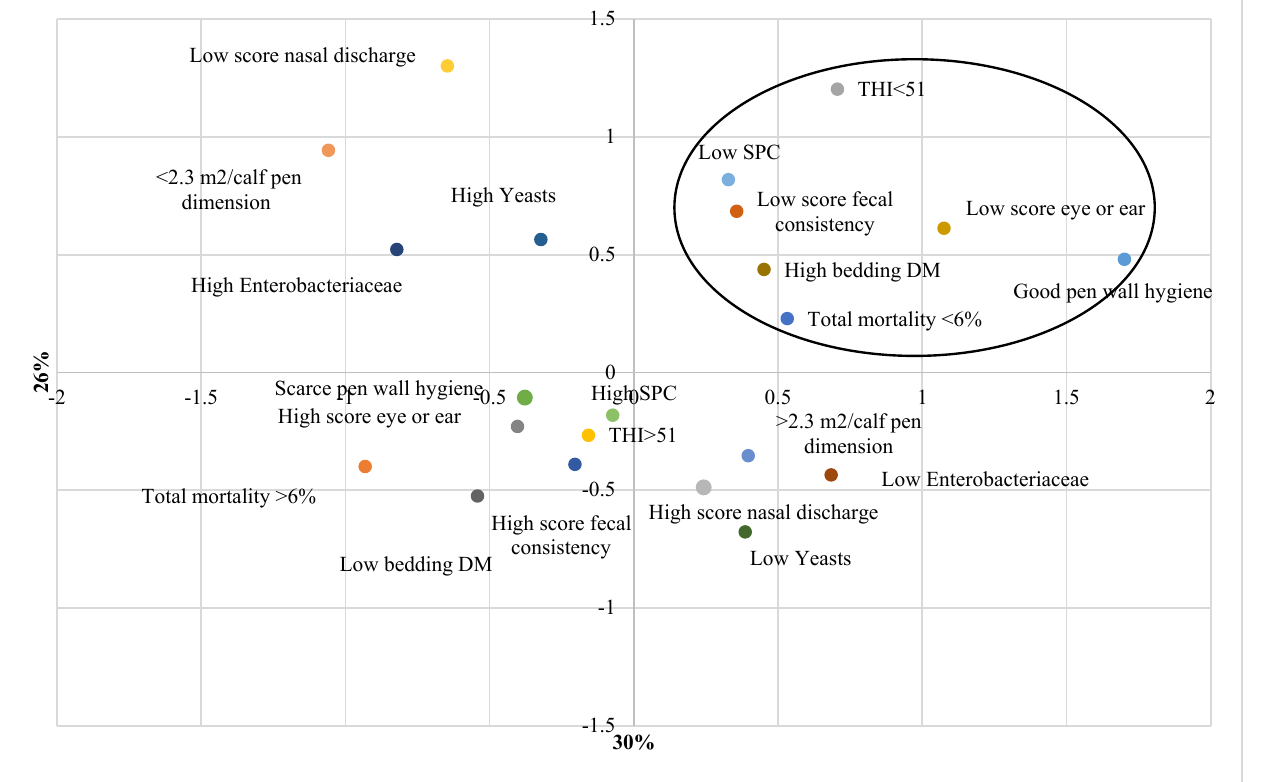
Figure 2. Multiple Correspondence Analysis highlighting the relationships among microclimate variables, pen area, pen hygiene, air microbial contamination, calf health scores and mortality. SPC = Standard Plate Count. THI = Temperature Humidity Index. DM = Dry Matter. SPC = Standard Plate Count.